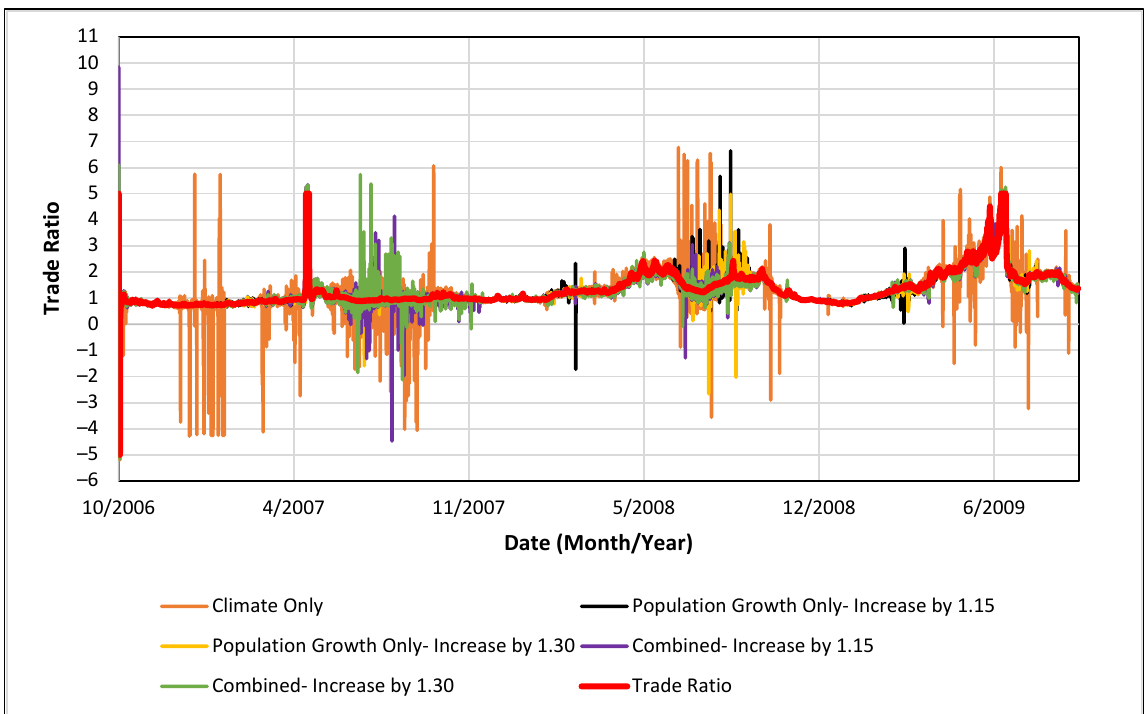
Figure 13. Composite Trade Ratio based on Sums for Delivery + Downstream Components with Equivalency Adjustments for Theoretical WQT Buyer BOD Combined with Suggested Margins of Safety for Climate and Population Characteristics over the Jordan River Simulation Period (1 October 2006 to 30 September 2009) for RCP 6.0.